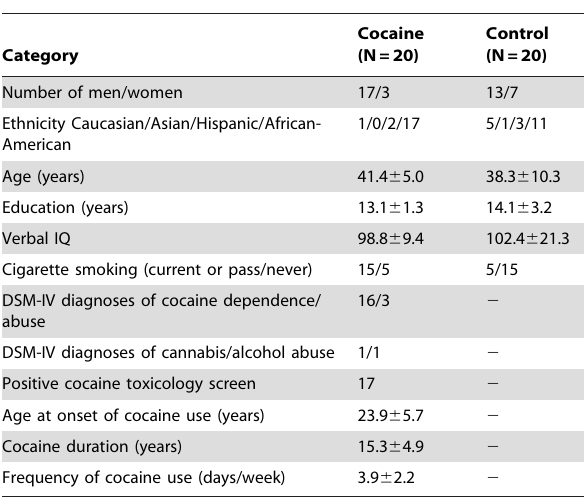
Table 1. Subject characteristics.